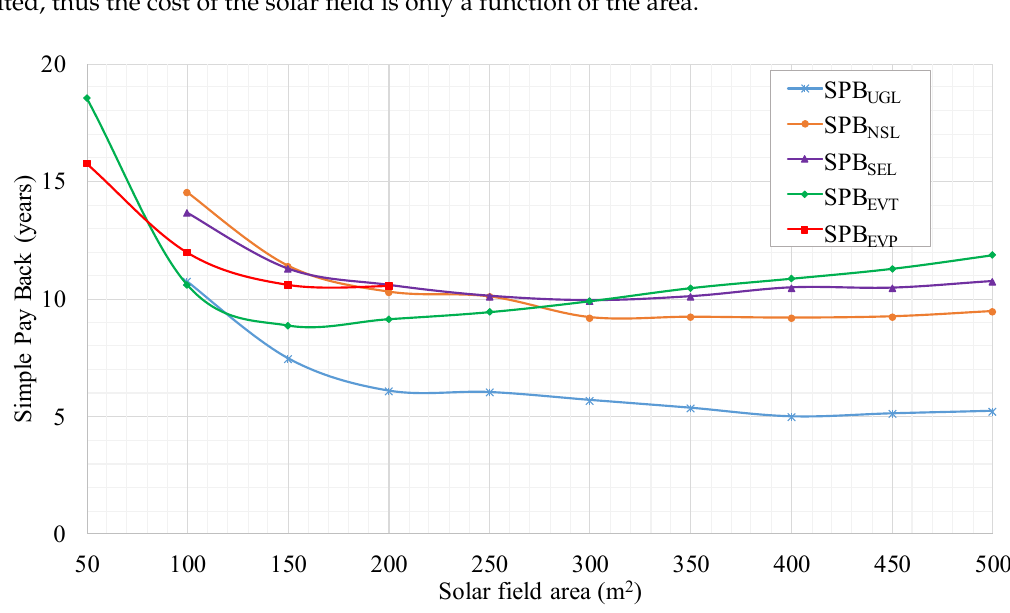
Figure 13 . Simple Pay Back period vs. solar field area, parametric analysis. Figure 13. Simple Pay Back period vs. solar field area, parametric